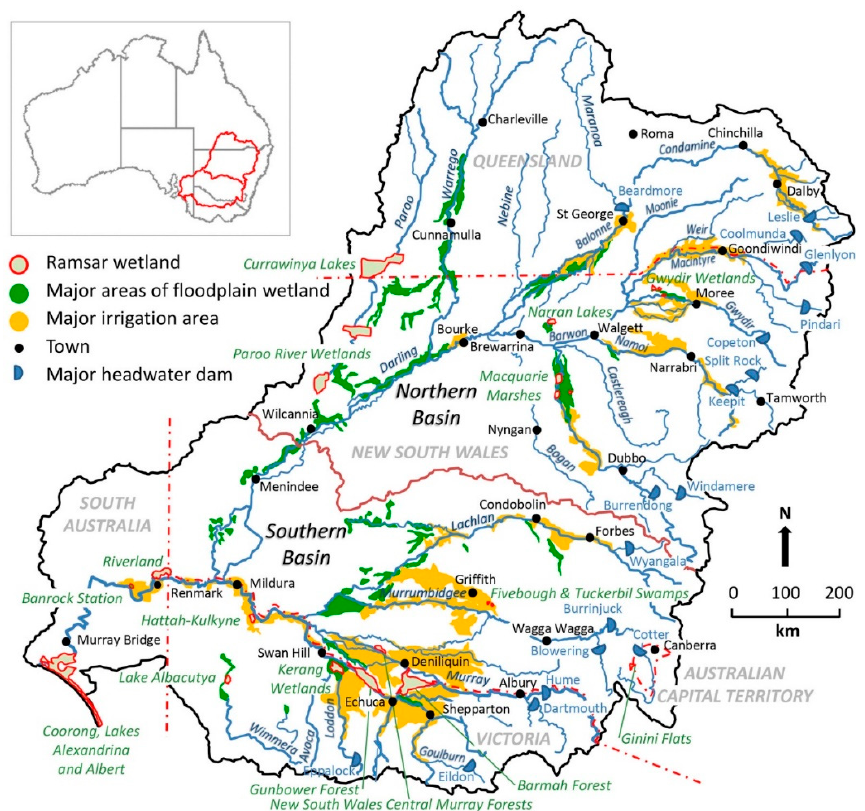
Figure 1. The Murray–Darling Basin showing major tributaries of northern and southern basins and proximity between major wetlands, floodplains, and irrigation districts. Note major headwater dams on most rivers, which supply irrigation water and environmental flows and major irrigation districts upstream of important wetlands. Inset: map of Australia showing the location of the Murray–Darling Basin.